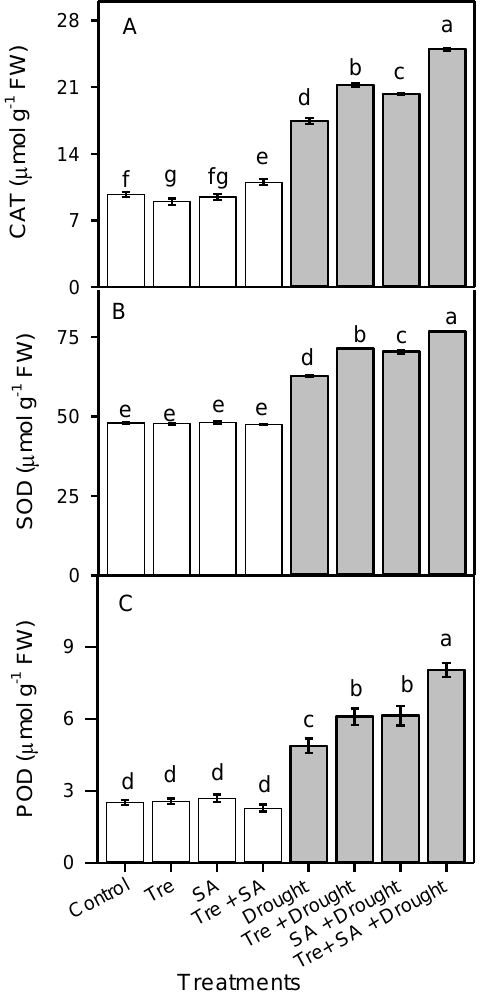
Figure 4. Catalase (CAT) ( A ), superoxide dismutase (SOD) ( B ), and peroxidase (POD) ( C ) activities in sweet basil ( Ocimum basilicum ) after foliar application of trehalose (Tre) and/or salicylic acid (SA) during drought stress. One month old seedlings were watered to 100% (control) or 60% (drought) field capacity for 20 days. Tre and/or SA were then applied twice with a 5 day interval. The watering conditions were maintained for an additional 2 weeks until plants were harvested. Data are the means ± SE ( n = 6). Different letters above the bars indicate significant differences among means according to Duncan’s multiple-range test at the p < 0.01 level.